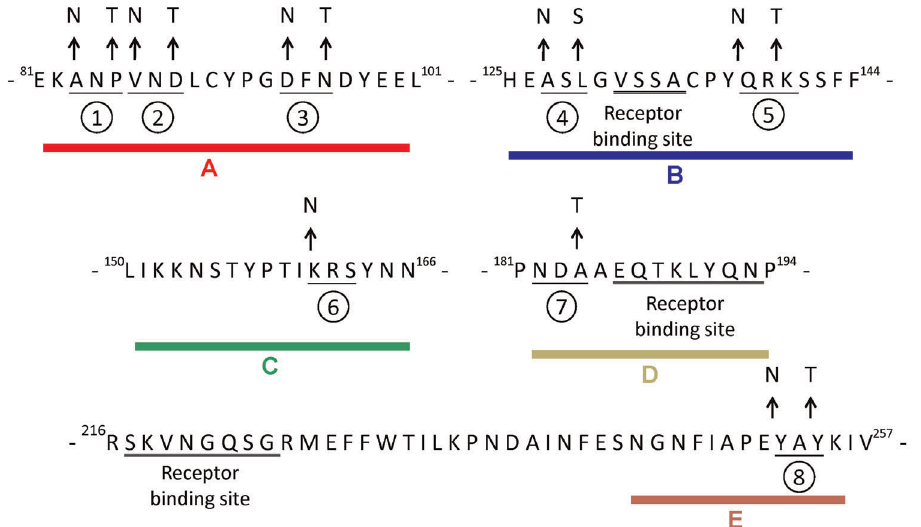
Figure 4. Hyperglycosylated DNA design. Site-directed mutagenesis in five HA1 subunit regions (A, B, C, D, E) was performed following the addition of N-linked glycosylation sites. Nine N-X-S/T motifs were created in the five regions: (1) 83NNT, (2) 86NNT, (3) 94NFT, (4) 127NSS, (5) 138NRT, (6) 156NTT, (7) 161NRS, (8) 182NDT, (9) 252NAT. Triplet amino acids are underlined. Arrows point away from wild-type sequences to amino acid changes resulting in N-linked glycosylation sequences.